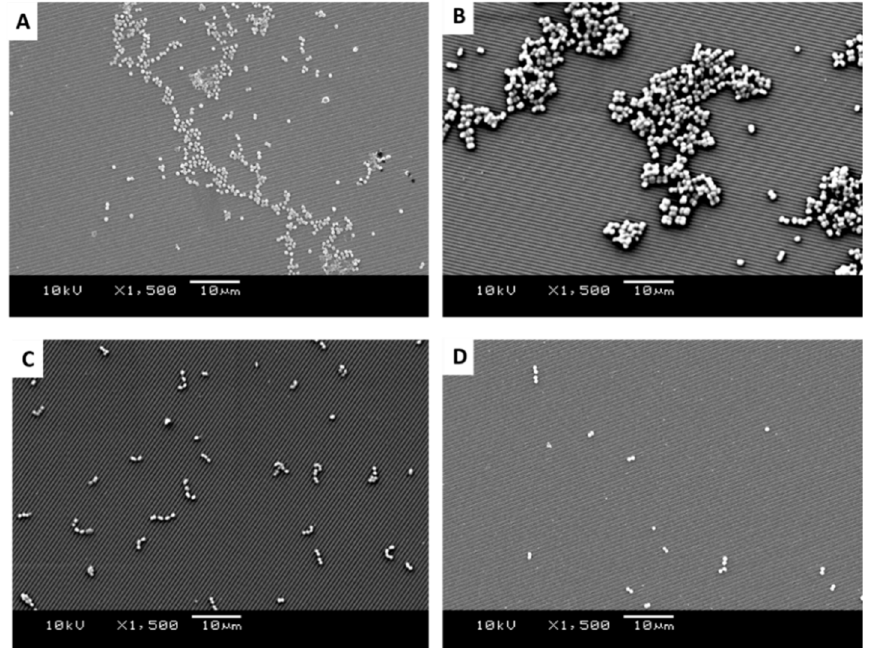
Figure 6. SEM images of retained bacteria on silica plates with titanium-coated grooves (0.59 µm):